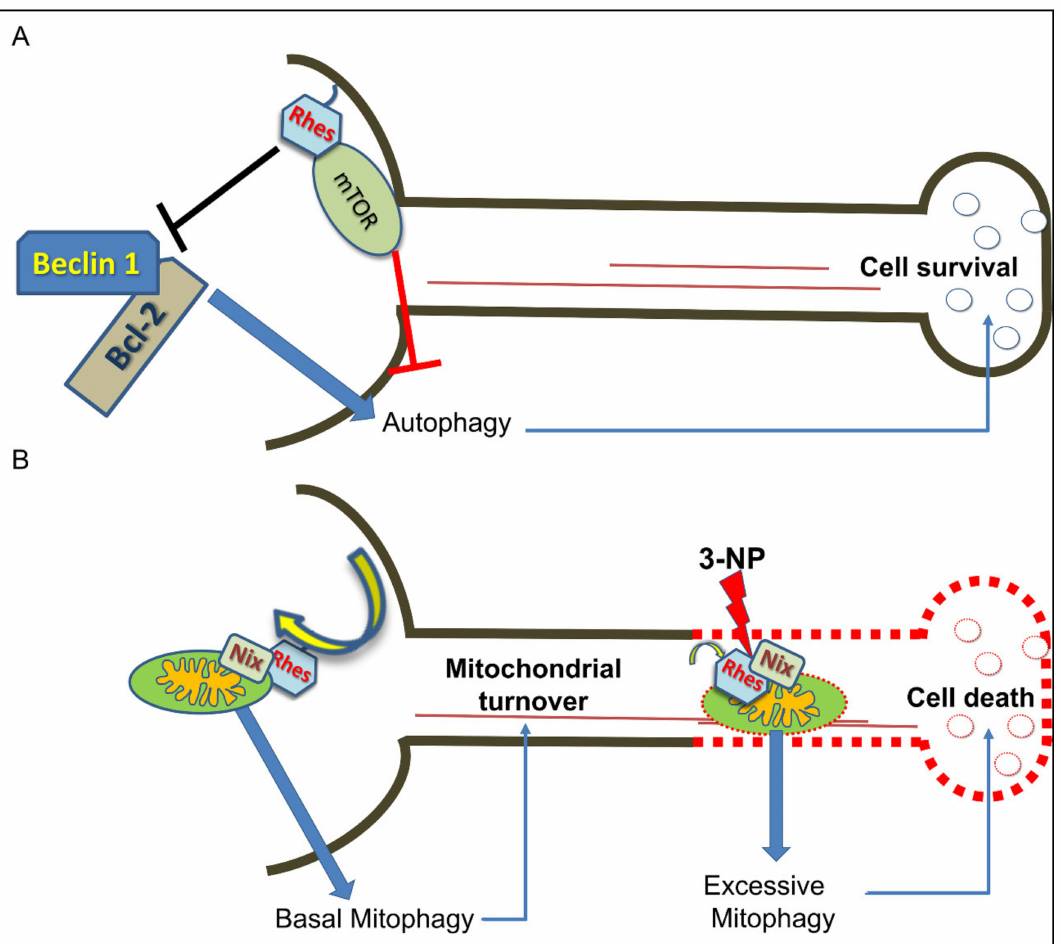
Figure 3. Rhes modulates striatal neuronal survival. ( A , B ) Working model, where Rhes is regarded as a key modulator of neuronal survival. ( A ) Rhes is able to bind to and activate mTOR, which normally inhibits autophagy. Moreover, it can also bind to Beclin-1 in particular cell conditions, hence displacing the inhibitory association between Bcl-2 and Beclin-1 that, eventually, activates autophagy in a mTOR-independent manner. Moreover, Rhes interacts with the mitophagy receptor, Nix, which drives autophagosomes to trigger basal mitochondrial degradation. ( B ) In the presence of mitochondrial toxin, 3-NP, such an interaction may bring about excessive mitophagy that, in turn, is able to promote neuronal cell